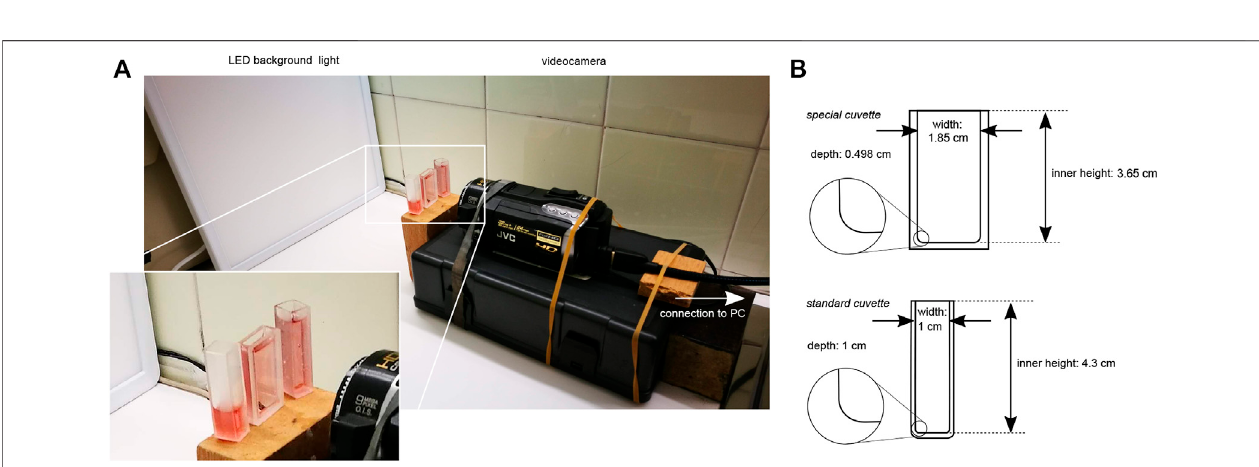
FIGURE2| Opticalsetup, (A) showsthearrangementoftheLEDbacklight,photospectroscopicquartzcuvettesandthevideocamera;insetshowsazoomonthe cuvettes, (B) shows the schemes of the cuvettes with their dimensions; insets show the curved inside corners.